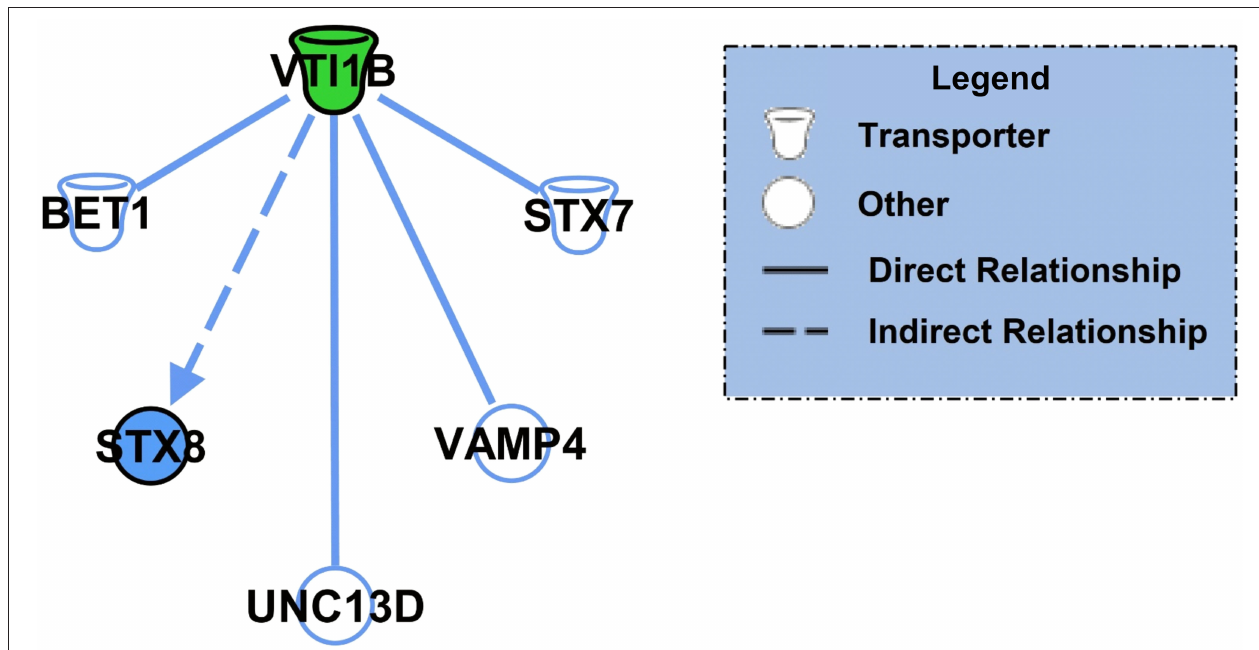
FIGURE 2 | The downstream effectors of the putative K48 polyubiquitin target protein in the amygdala of females. Using IPA, the downstream proteins of VTI1B, which had the largest increase in abundance following K48 purification 1h after the training in females, were identified. Green denotes a decrease in the protein expression levels, which leads to inhibition of the effector protein (shown in blue). Direct relationships are shown with solid lines and the indirect relationship is indicated by a dotted